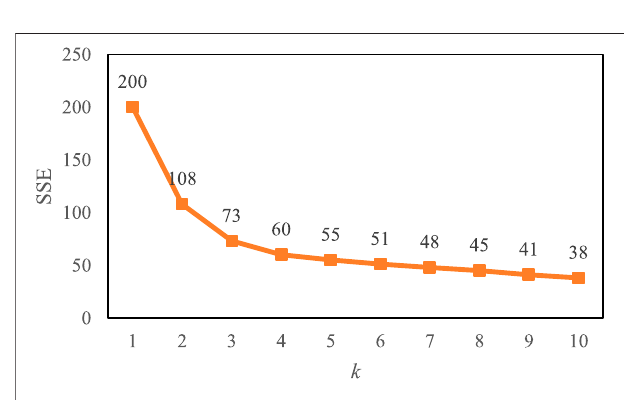
FIGURE 5 | Relationship between the number of clusters and the SSE